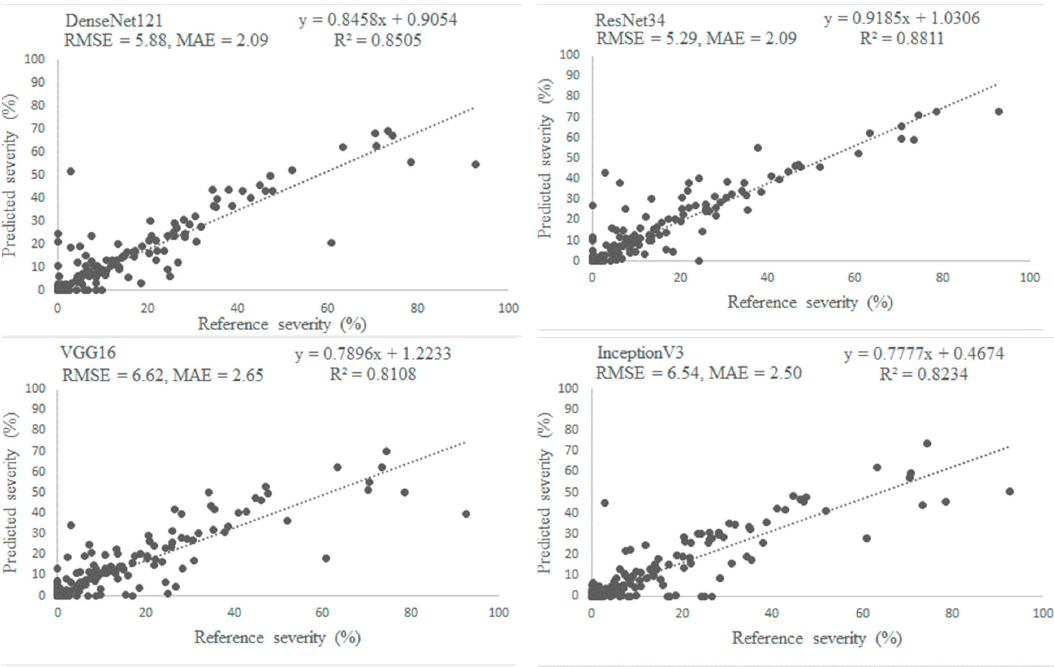
Figure 8. Scatter plots of the first ‐ order regression line for the relationship between reference severity obtained from reference masks (manually annotated) and the severity estimated by using the LinkNet model and different backbones.